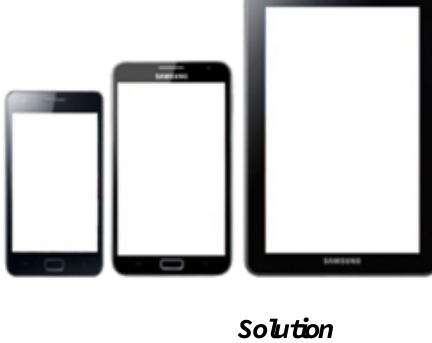
Figure 2. Comparison of device sizes (GALAXY S, GALAXY Note and GALAXY Tablet).